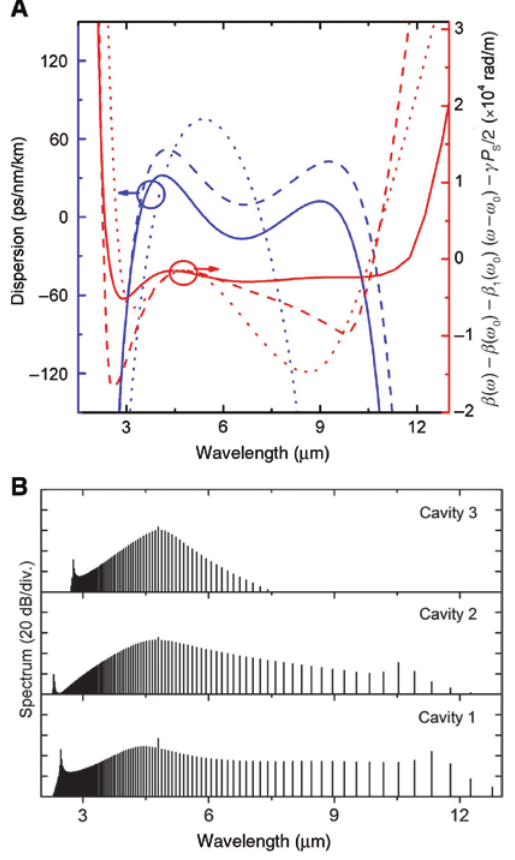
Figure 8: Frequency comb generation in three cavities. (A) Dispersion curves for cavity 1 (solid line), cavity 2 (dashed line), and cavity 3 (dotted line) and (B) generated frequency comb spectra for cavities 1 to 3, with a pump power of 300 mW at 4.8 μ m.